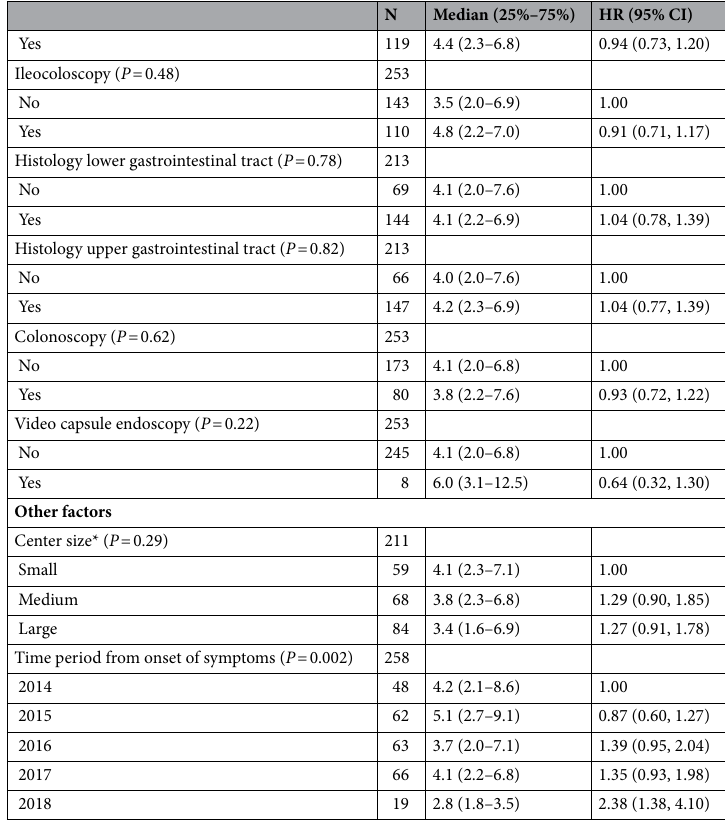
Table 3. Univariate analysis of factors influencing diagnostic delay (in months) in children and adolescents with Crohn’s disease (Hazard ratio < 1: longer, hazard ratio > 1: shorter). *small = < 25 PIBD patients per year; medium = 25–100 PIBD patients per year; large = > 100 PIBD patients per